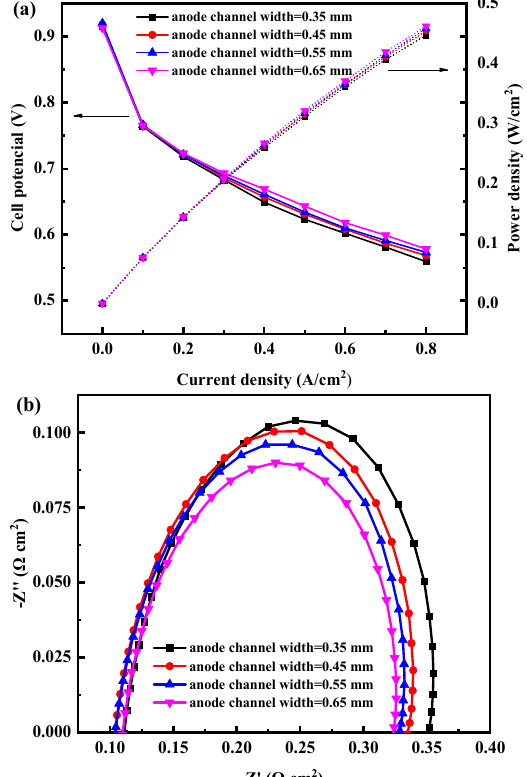
Figure 7. ( a ) Polarization and ( b ) power density curves of the open-cathode PEMFC with different anode serpentine channel widths.